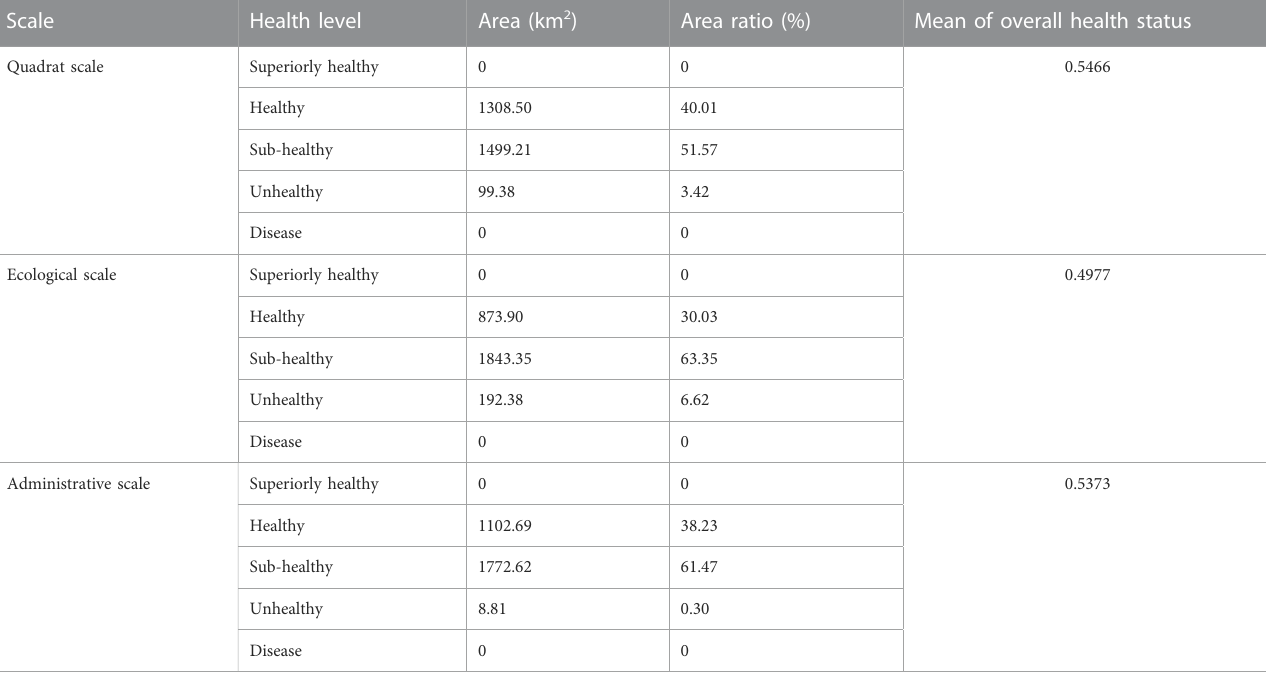
TABLE 7 Ecosystem health area and its proportion at different